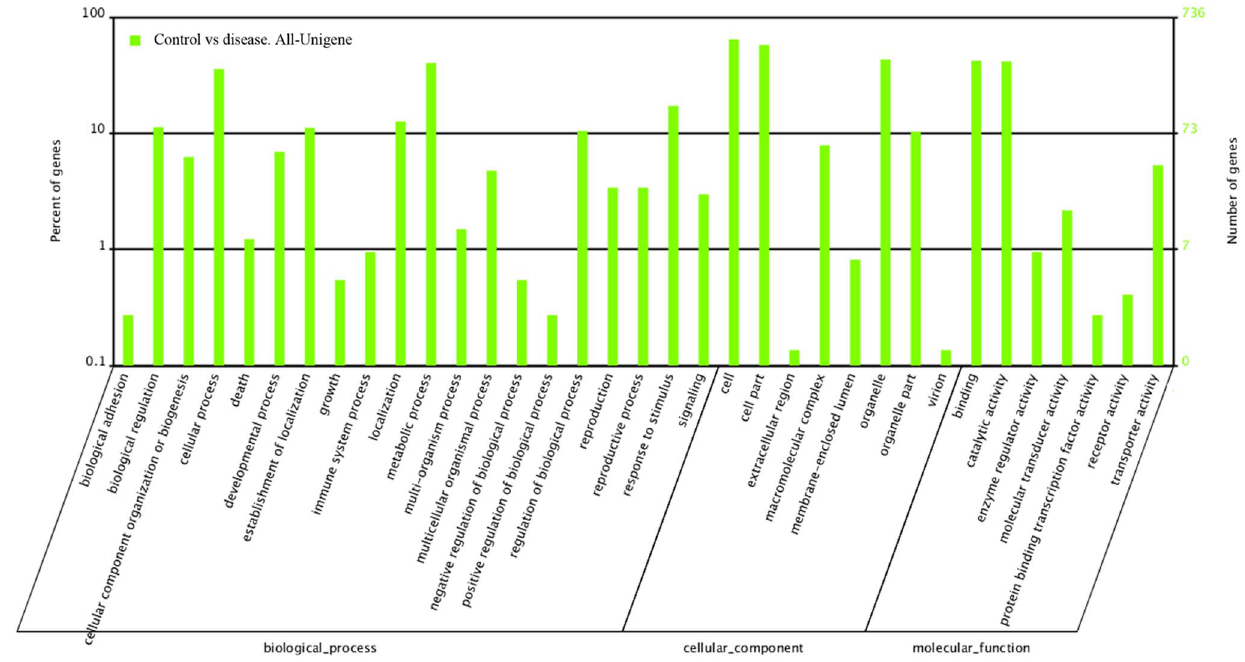
Figure 3. Functional categorization of the genes with significant transcriptional changes between the normal control (CK) and surface brown spots disease (SBS, dis) fruit. The genes were categorized based on Gene Ontology (GO) annotation, and the proportion of each category is displayed based on the following: Biological process; Molecular function; Cellular component. doi:10.1371/journal.pone.0074217.g003 Gene Ontology (GO) functional analysis and Kyoto Encyclopae- chies for biological process, cellular component and molecular dia of Genes and Genomes (KEGG) pathway analysis. The GO function. The biological interpretation of the DEGs was further categorization results are expressed as three independent hierar- completed by assigning them to metabolic pathways using KEGG. Table 2. List of the important KEGG pathways with more than 3 differentially expressed genes.